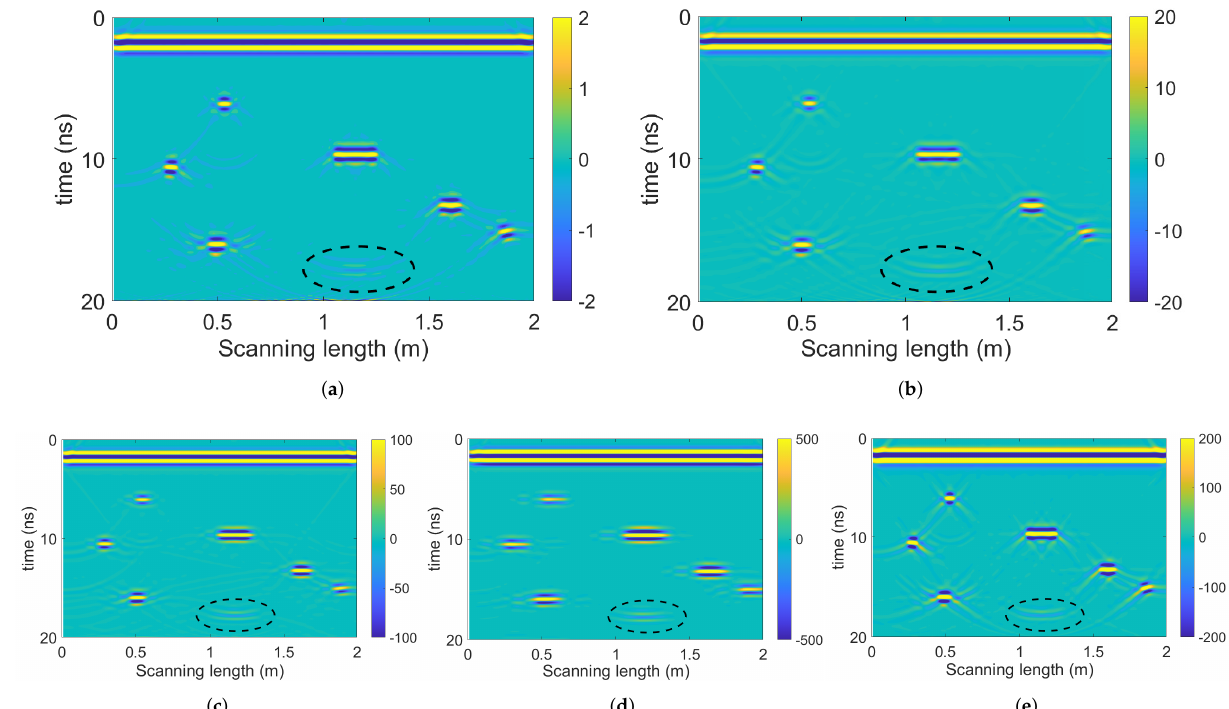
Figure 6. F-K migration results of ( a ) 1st-layer DH 1 , ( b ) 2nd-layer DH 2 , ( c ) 3rd-layer DH 3 , ( d ) 4th-layer DH 4 , and ( e ) pre- processed radargram without SWT decomposition.